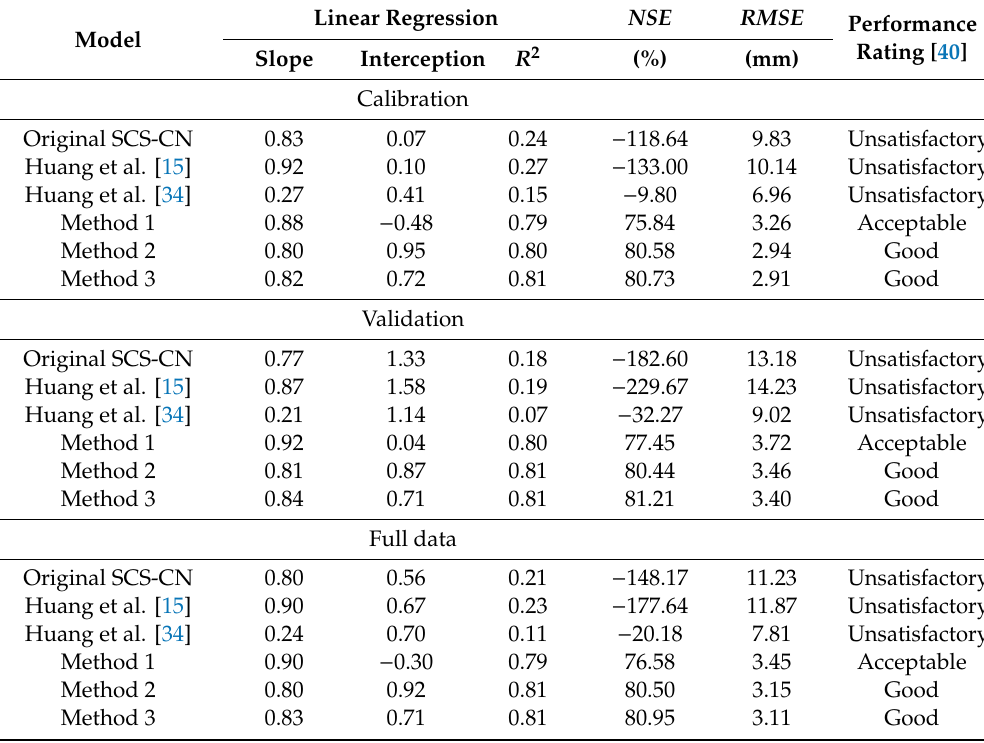
Table 3. The performance of the tested method for the calibration and validation datasets. Model